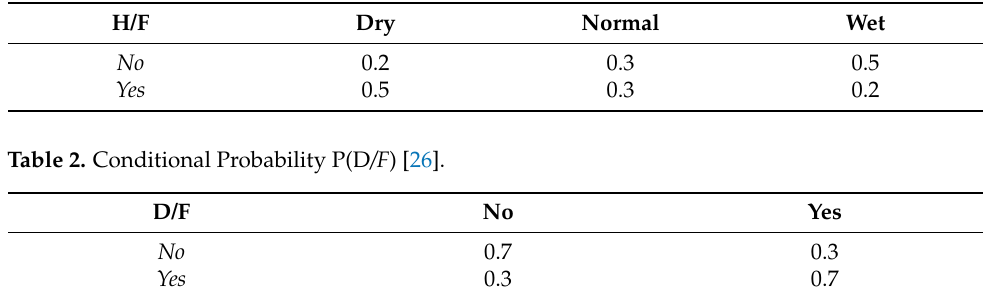
Table 2. Conditional Probability P(D /F ) [26].